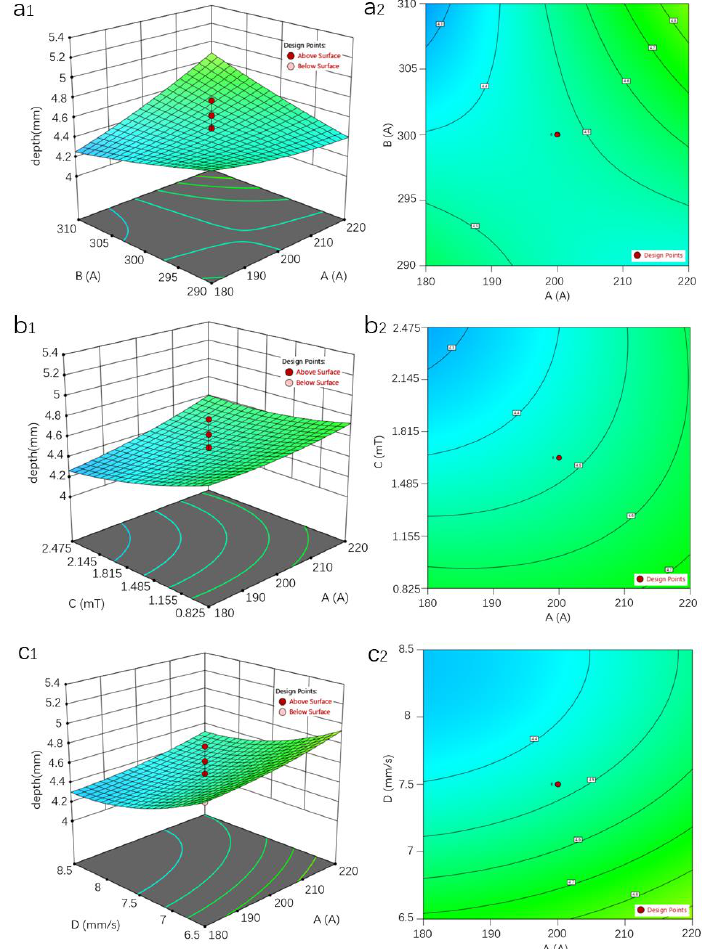
Figure 6. Interactive response surface and contour map of different factors: ( a 1 , a 2 ) are the interactive response surfaces and contour maps of A: plasma current and B: MIG current, respectively; ( b 1 , b 2 ) are the interactive response surfaces and contour maps of factors A: plasma current and C: magnetic field intensity, respectively; ( c 1 , c 2 ) are the interactive response surfaces and contour maps of factors A: plasma current and D: welding velocity, respectively.